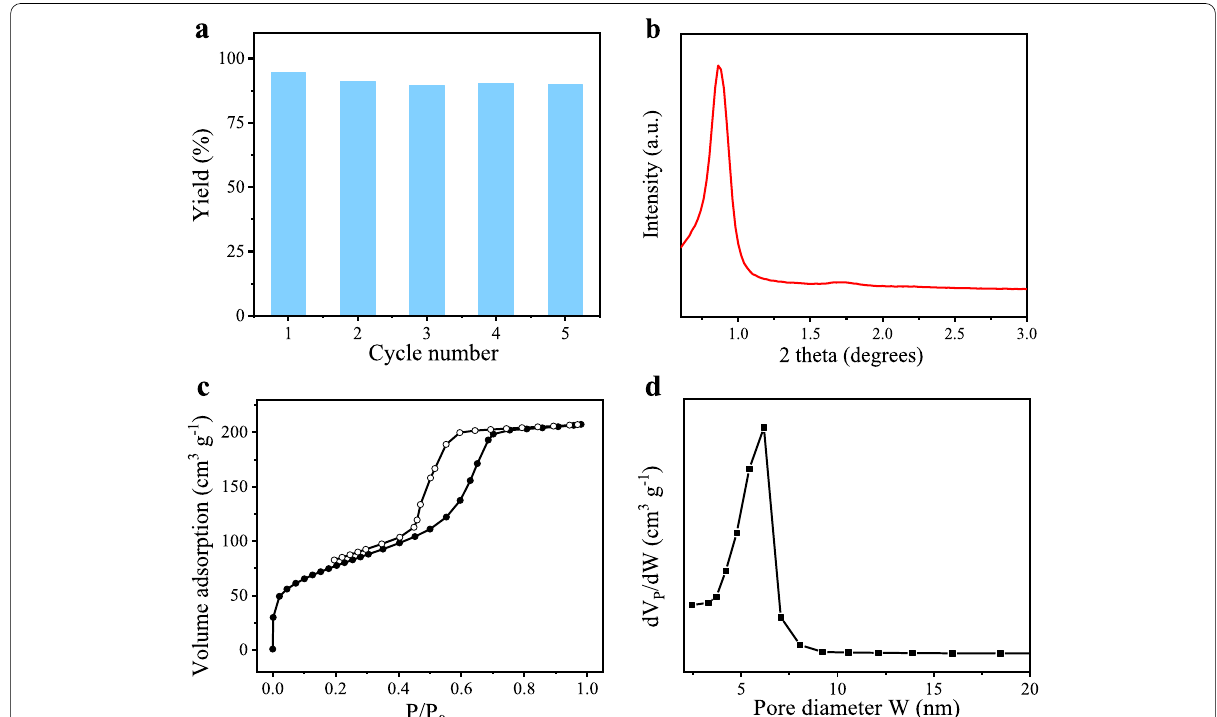
Fig. 5 a Catalytic reusability of 15%PIL-90@FDU-15-600. Reaction conditions: styrene oxide (5 mmol), catalyst (0.4 mol%), 110 oC, 1 bar CO2 (balloon), 24 h. b Small-angle PXRD pattern. c N2 sorption isotherm and d pore size distribution curve of spent 15%PIL-90@FDU-15-600 recovered after the 5 th